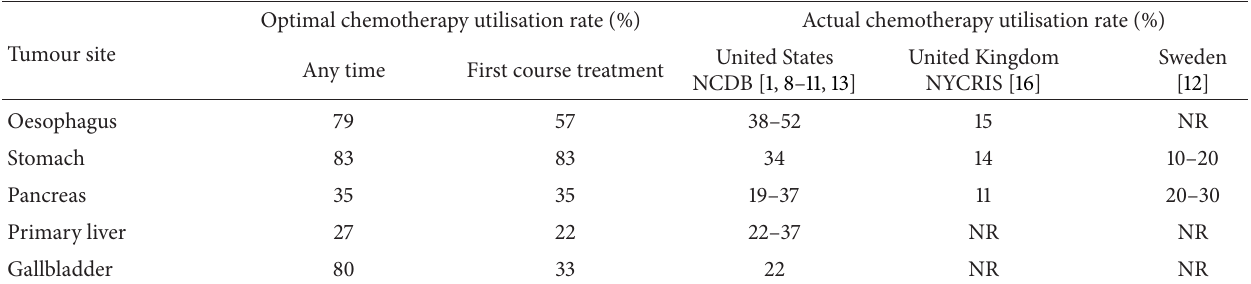
Table 3: Comparison of optimal and actual chemotherapy utilisation rates for upper gastrointestinal cancers.